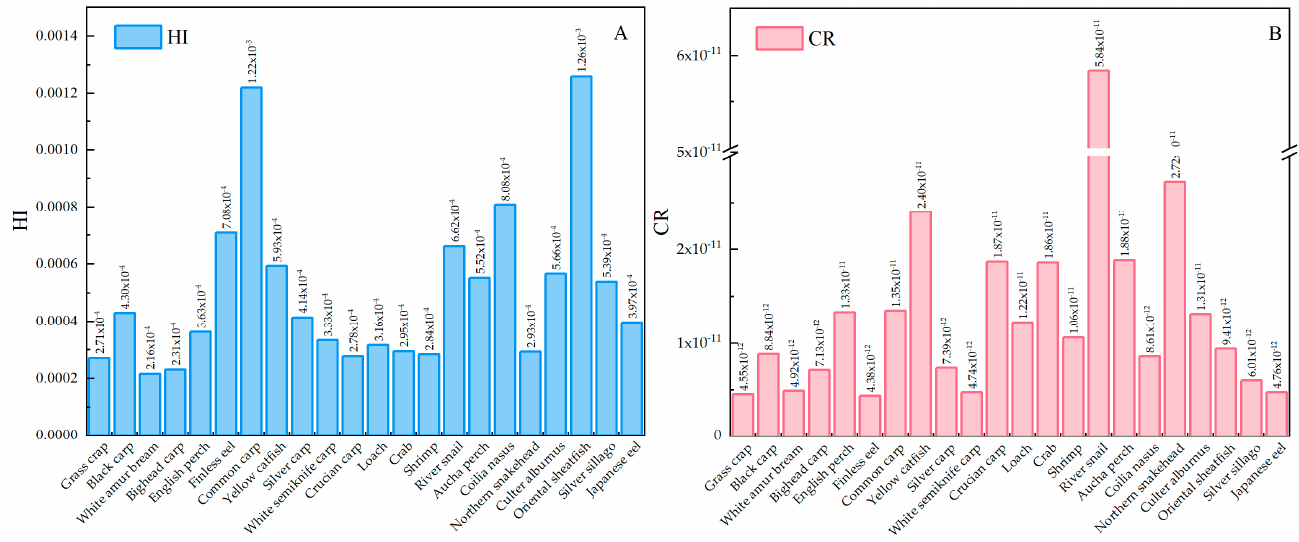
Figure 5. Noncarcinogenic and carcinogenic risks of PBDEs in aquatic organisms collected from typical shallow lakes (( A ) shows the noncarcinogenic risk values of PBDEs, and ( B ) shows the carcinogenic risk values of BDE-209).